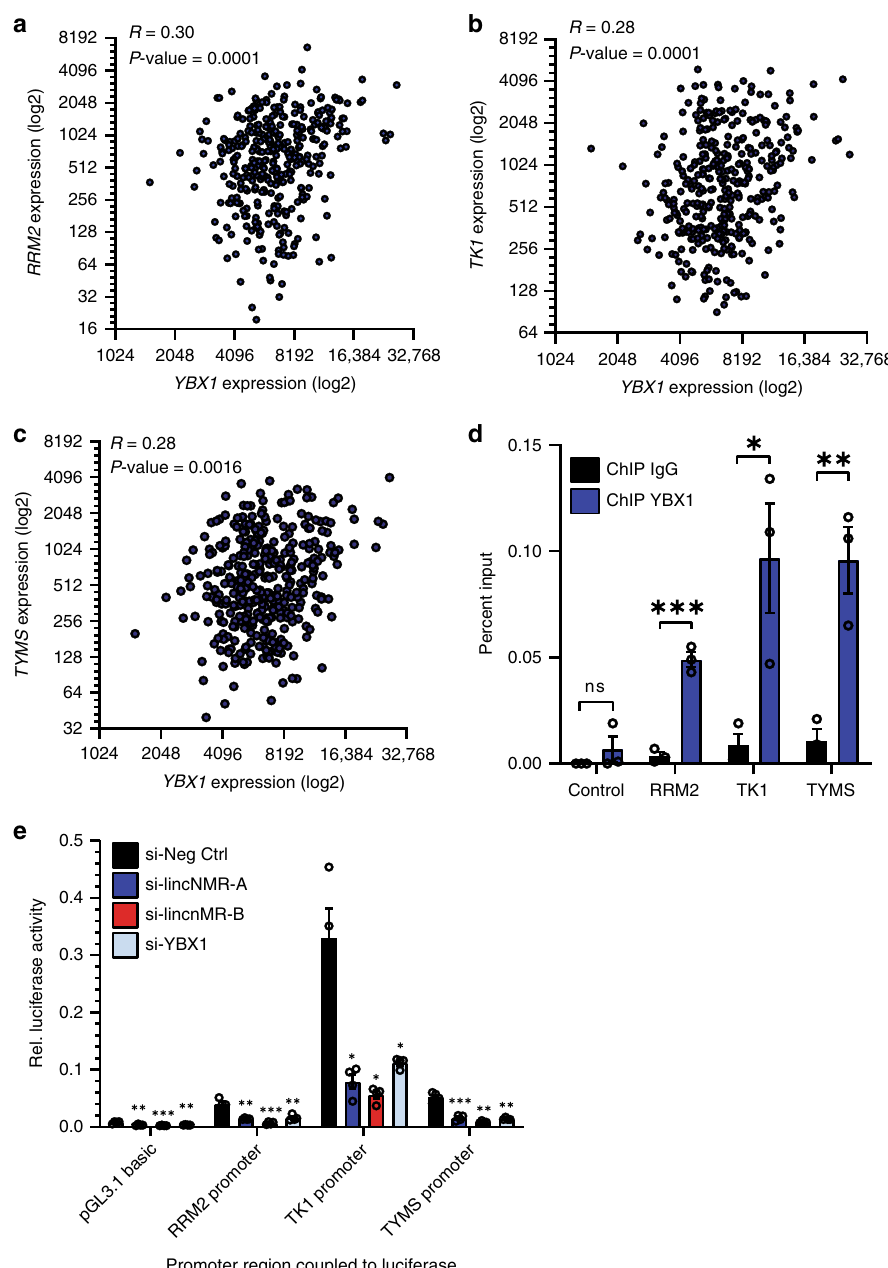
Fig. 6 YBX1 correlates with, binds to and activates the promoters of RRM2 , TK1 , and TYMS . a YBX1 mRNA expression signi fi cantly and positively correlates with RRM2 mRNA expression in n = 374 hepatocellular carcinoma patient samples (TCGA LIHC, indicated: log2 expression). Signi fi cance was calculated by unpaired, two-tailed t test. b YBX1 mRNA expression signi fi cantly and positively correlates with TK1 mRNA expression in n = 374 hepatocellular carcinoma patient samples (TCGA LIHC, indicated: log2 expression). Signi fi cance was calculated by unpaired, two-tailed t test. c YBX1 mRNA expression signi fi cantly and positively correlates with TYMS mRNA expression in n = 374 hepatocellular carcinoma patient samples (TCGA LIHC, indicated: log2 expression). Signi fi cance was calculated by unpaired, two-tailed t test. d The binding of YBX1 to the promoters of RRM2 , TK1 , and TYMS was determined by chromatin immunoprecipitation (ChIP) in HLE cells. Bar graph represents qPCR data after YBX1 ChIP compared with IgG as a negative control ( n = 3). Data represent mean, and error bars represent SEM. Signi fi cance was calculated by unpaired, two-tailed t test where * P < 0.05; ** P < 0.01; *** P < 0.001. e Luciferase assays show decreased transactivation of RRM2 , TK1 , and TYMS promoter regions after lincNMR or YBX1 silencing with 10 nM siPOOLs in HLE cells ( n = 4). Data shown are ratios of fi re fl y luciferase divided by Renilla luciferase used for standardization. Data represent mean, and error bars represent SEM. Signi fi cance was calculated by unpaired, two-tailed t test where * P < 0.05; ** P < 0.01; *** P < OIS 50 – 52 due to a suppression of RRM2 as a driver and not as Consequently, all four dNTPs are depleted upon lincNMR knockdown, consolidating its role in the nucleotide metabo- an effect of cell cycle exit 51 . Depleting p53 or pRB, two key factors in senescence, does not affect lincNMR -controlled lism axis. Our fi ndings are in line with previous studies, fi nding levels of all four dNTPs signi fi cantly decreased during senescence in good accordance with a previous study showing